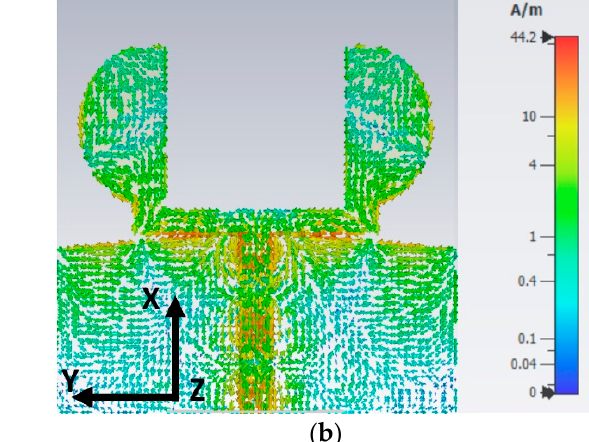
Figure 13. Current distributions at 10 GHz for the UWB antenna array: ( a ) Antenna array with single-wing filter, ( b ) An- tenna array without filter.